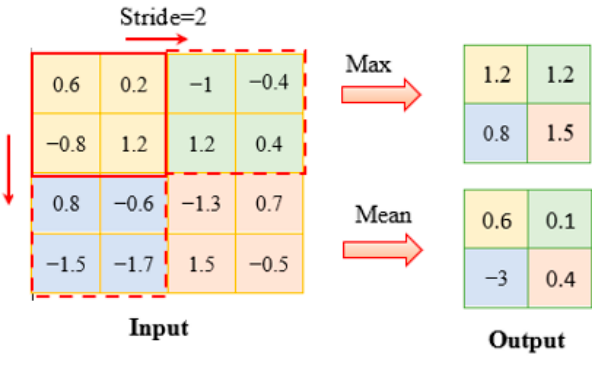
Figure 11. Pooling layer.